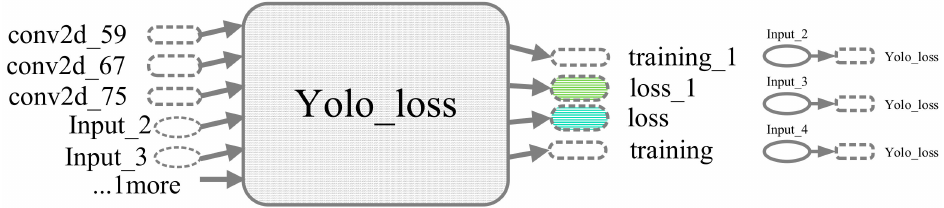
Figure 6. YOLO v3 loss visual format in TensorBoard.